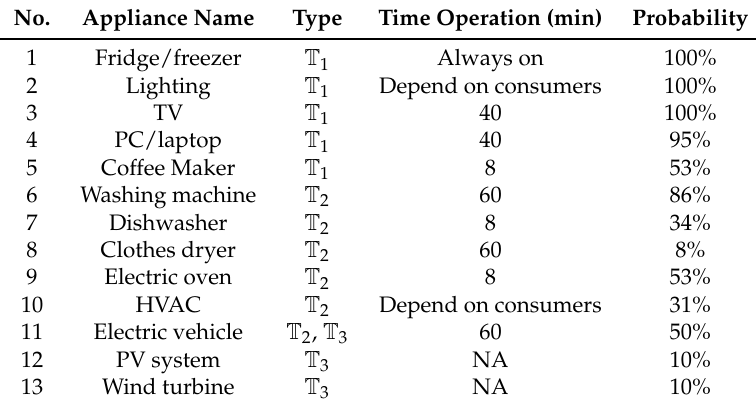
Table 2. Parameters of appliances